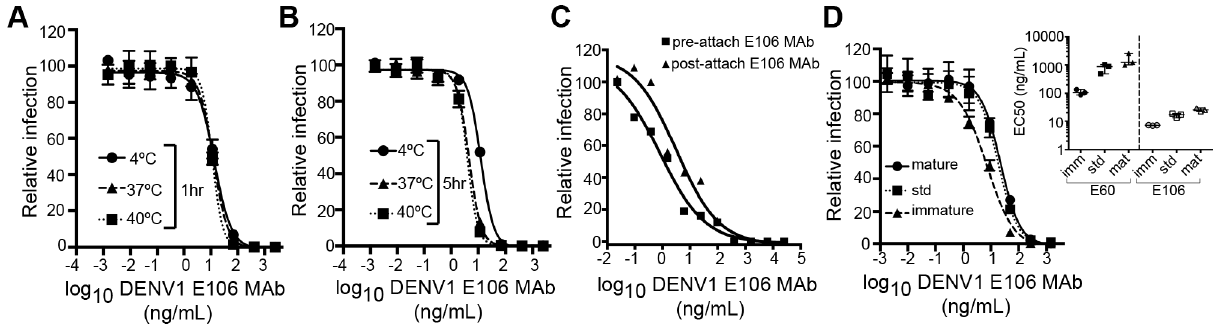
Figure 5. Functional characteristics of neutralization by E106 MAb. ( A–B ) Time and temperature dependence of neutralization. DENV-1 RVPs were pre-incubated with E106 MAb for one ( A ) or five hours ( B ) at three different temperatures (4 u C, 37 u C and 40 u C) before infecting Raji-DCSIGNR cells. Infection was carried out at 37 u C and assessed 48 h later by flow cytometry. Error bars represent the standard error of the mean of duplicate infections. Results are representative of two independent experiments. ( C ) Pre- or post-attachment neutralization test. BHK21-15 cells were pre- chilled to 4 u C, and 10 2 PFU of DENV-1 (strain 16007) was added to each well for one hour at 4 u C. After extensive washing at 4 u C, increasing concentrations of E106 MAb were added for one hour at 4 u C, and the PRNT determined (triangles, Post). A standard pre-incubation PRNT with all steps performed at 4 u C is shown for reference (squares, Pre). Data shown are representative from three experiments performed in duplicate. ( D ) E106 MAb neutralization is insensitive to the maturation state of the virus. E106 MAb neutralization of immature, standard, and mature 16007 RVP preparations, independently validated with the fusion-loop specific E60 MAb, are shown. A representative neutralization assay of three experiments is depicted. Error bars represent the standard error of the mean of duplicate infections. The inset depicts the EC50 values of neutralization of the distinct RVP preparations (immature, standard and mature) by E106 MAb and the control E60 MAb.